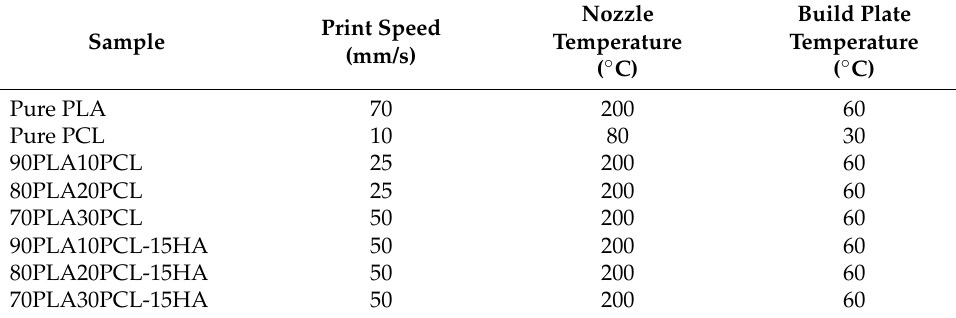
Table 2. Print settings for the